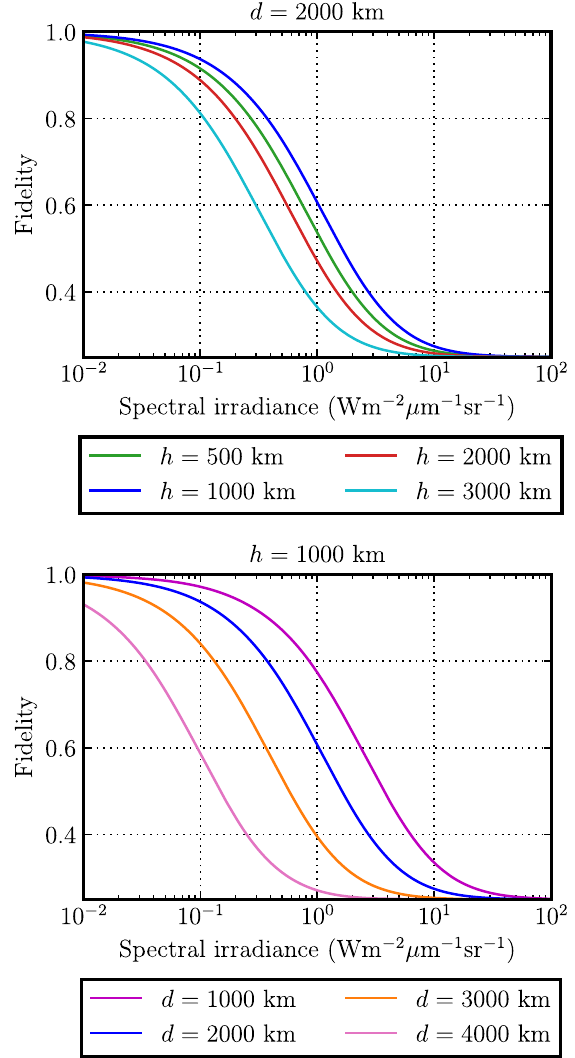
Fig. 10 Fidelity of satellite-to-ground entanglement transmission as a function of spectral irradiance. We consider transmission of the Bell state Φ + according to the scenario depicted in Fig. 8. The fi delity is given in eq. (29), and the average background photon number is given by n ¼ R Δ T , with R given by eq. (34). In order to calculate R , we let λ = 810 nm, Δ λ = 1 nm, Ω fov = 100 μ sr, r = 0.5 m, and Δ T = 1 ns; see, for e.g., refs 70,99,110 .